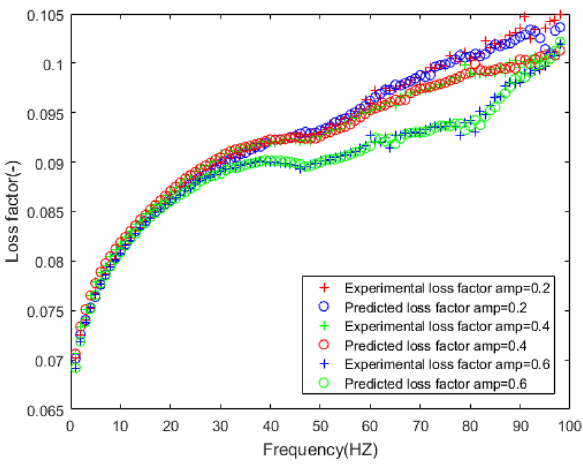
Figure 14. Comparison of prediction results and experimental results of loss factor under different amplitudes.